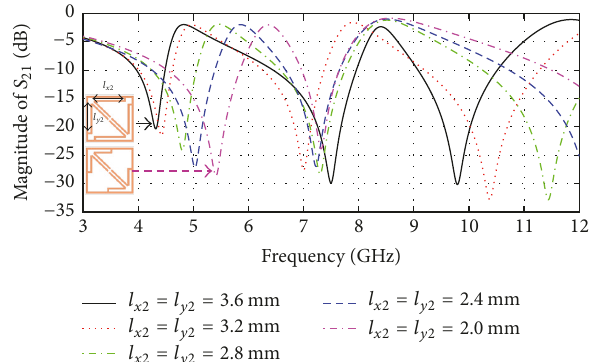
Figure 8: Transmission spectra of the TBEMR for different values of arm length 𝑙 𝑠 of the open delta loop.